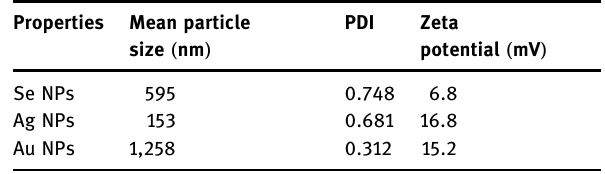
Table 1: Physicochemical properties of the synthesized three dif